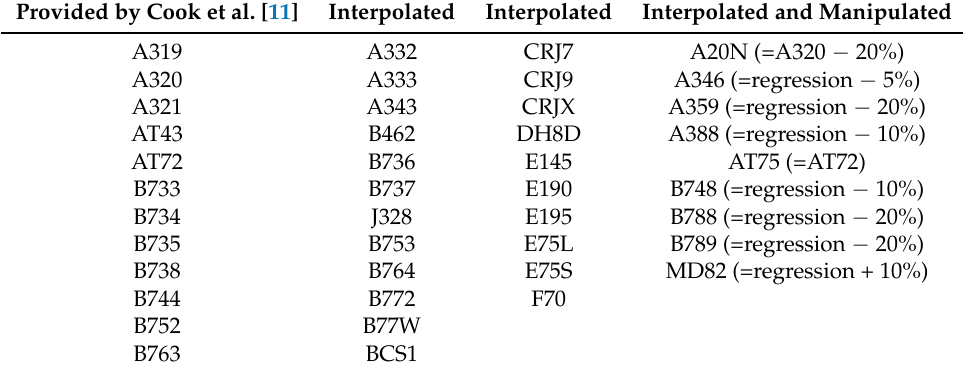
Table 2. Aircraft types considered in this study. Since Cook et al. [11] do not provide cost components for each aircraft type, some fuel burn values have been interpolated and others additionally manipulated. Provided by Cook et al.